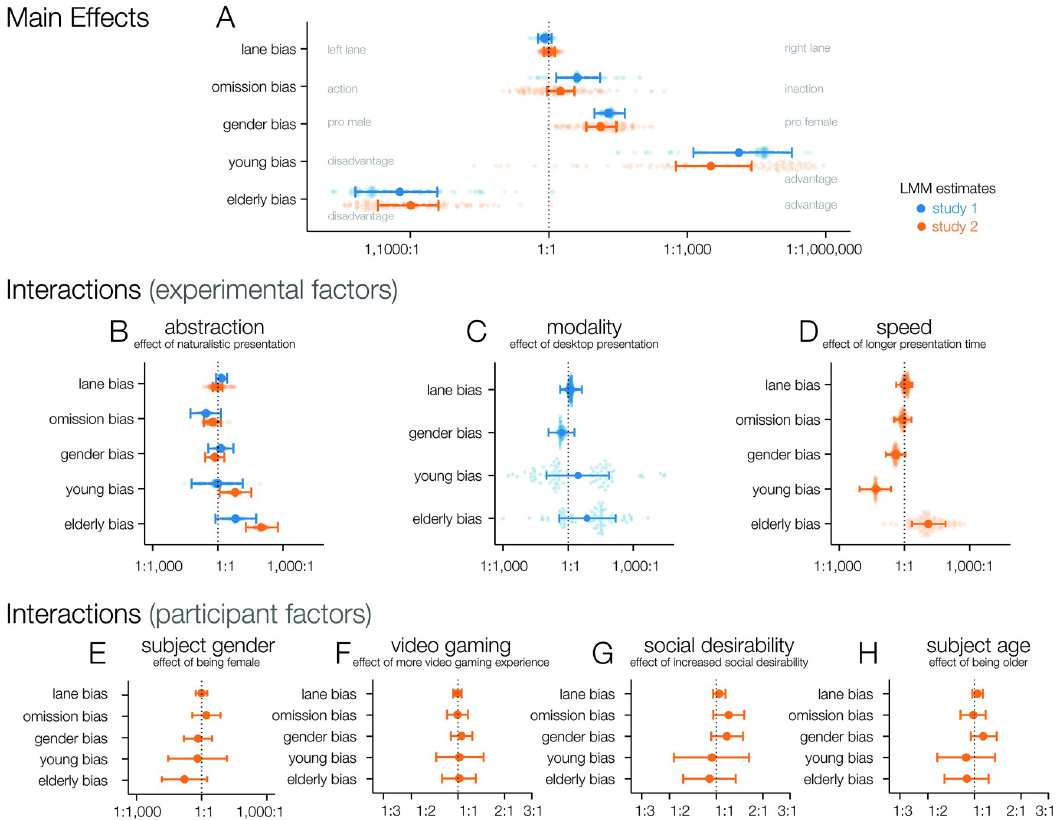
Fig 3. Bayesian hierarchical logistic regression results. A) Main effects of a logistic linear mixed regression model for both studies. Error bars indicate 95% credible intervals around the median posterior estimate of the group estimate. Dots indicate estimations of the individual participants’ parameters. B-D) Interactions of experimentally controlled factors. E-H) Between subject factors, note the different scale for F-H and that these are slopes (effects per unit) and not categorical